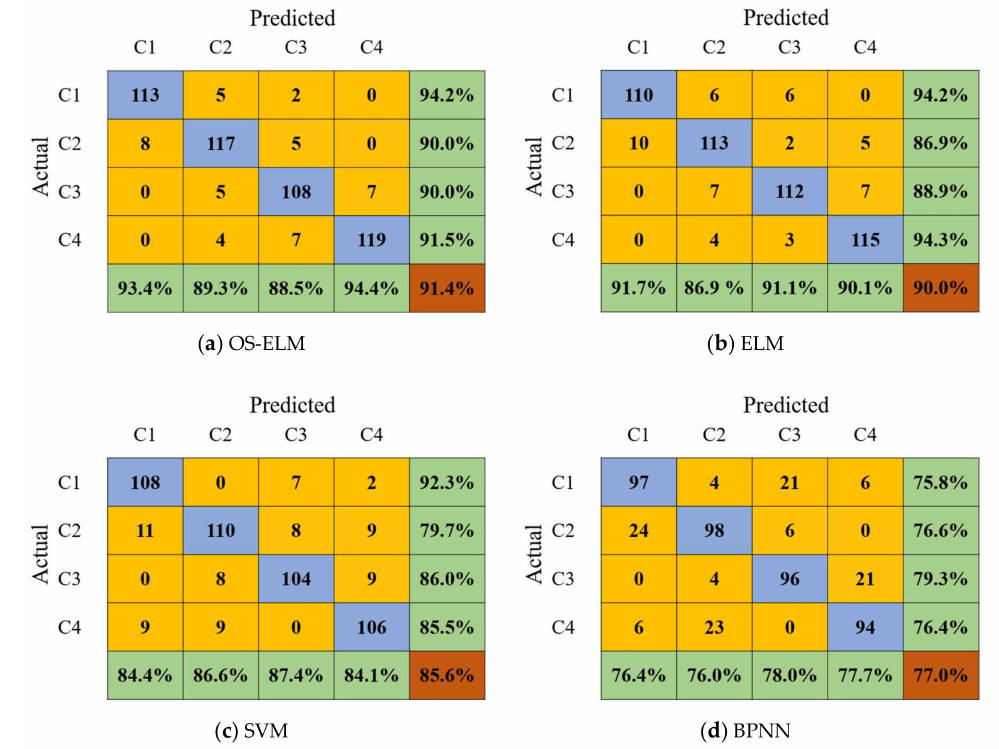
Figure 8. Pattern recognition result of four